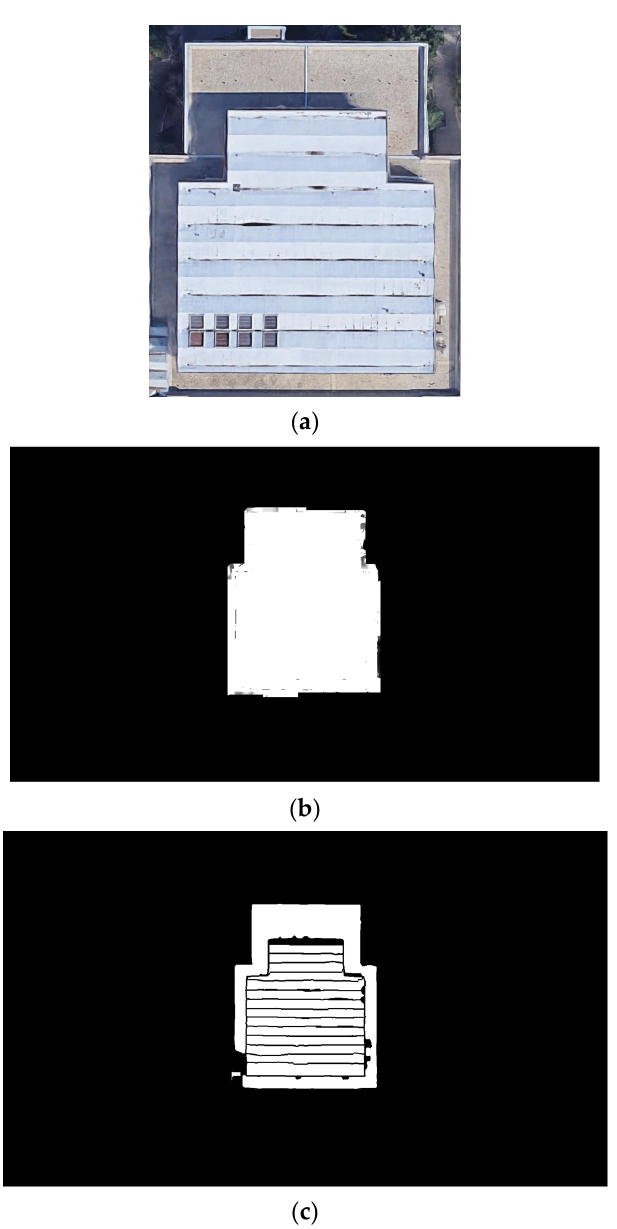
Figure 8. CAM building ( a ) satellite image (Imagery ©2021 Google, Imagery ©2021 Maxar Tech- nologies, Map data ©2021), ( b ) binary map before roof identification, and ( c ) binary map after roof